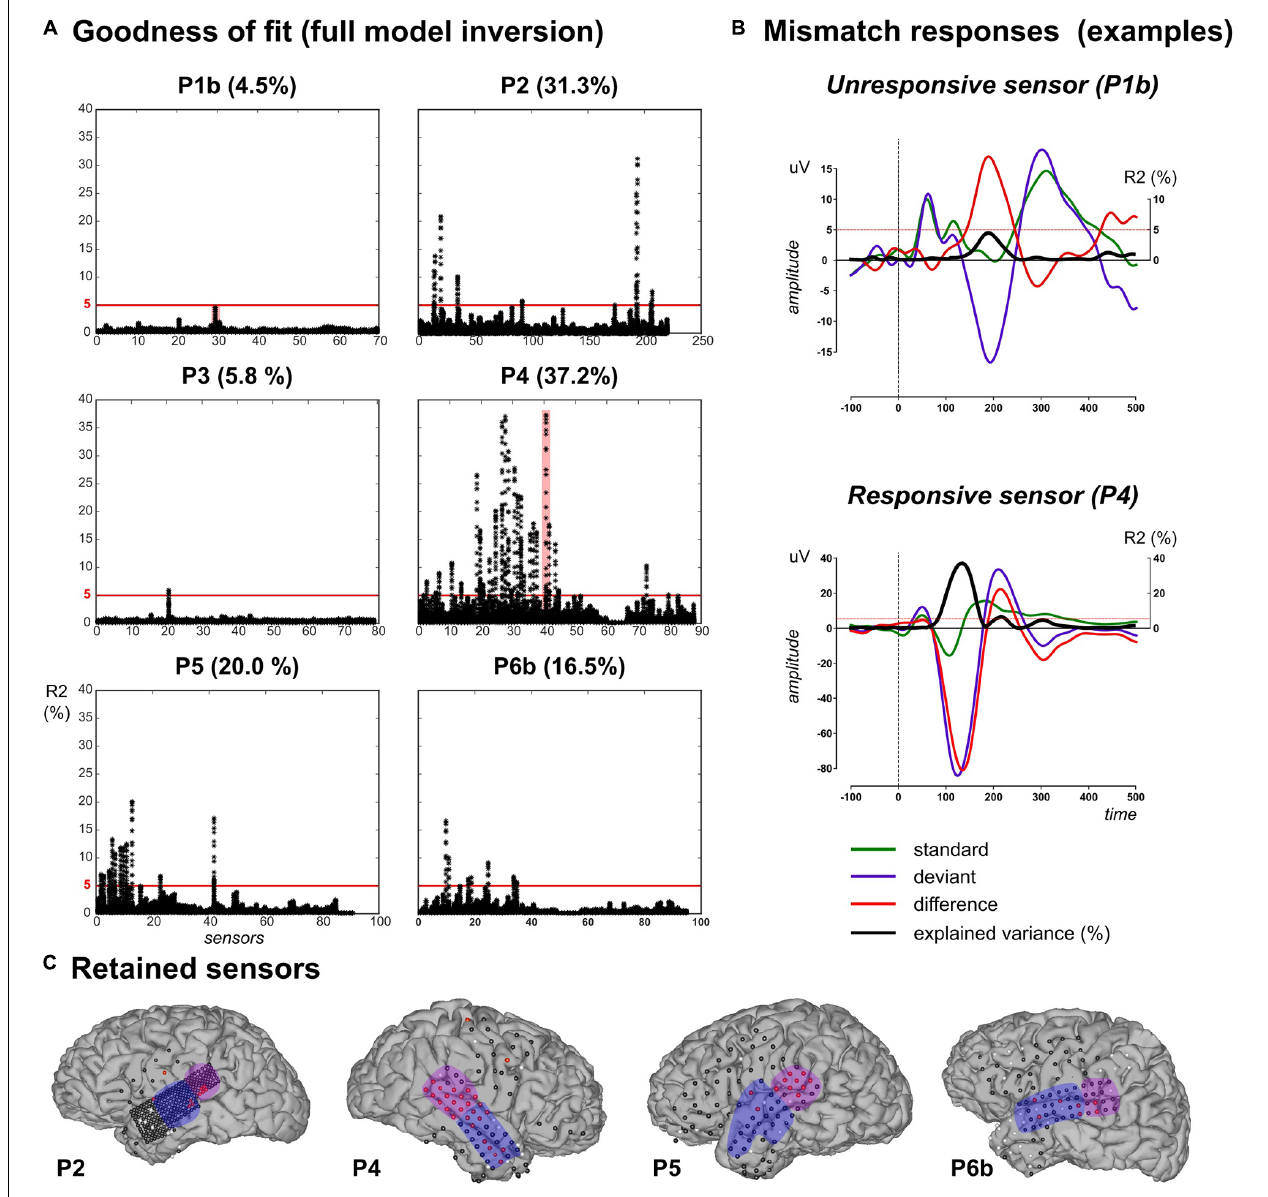
FIGURE 4 | Data selection based on goodness-of-fit in the full model inversion. (A) For each patient, explained variance (R2 percentage value) measured at each sensor ( x -axis) for each peri-stimulus sample inversion (N s = 120 black dots covering the [–100, 500] ms epoch per sensor). (B) Evoked responses elicited by standard (green), deviant (purple) and their difference (red) for two unresponsive (in P1b, upper plot) and responsive (in P4, lower plot) sensors. These two sensors are highlighted (red shaded areas) in panel (A) . Black trace indicates the R2 time-course. Red horizontal lines indicate the 5% threshold. (C) Cortical surface with sensor overlay in the four patients included in the present work. Selected sensors based on R2 thresholding are depicted in red, unresponsive and bad (rejected) sensors are in black and white, respectively. The present findings were measured in the anterior (blue) and posterior (purple) temporal